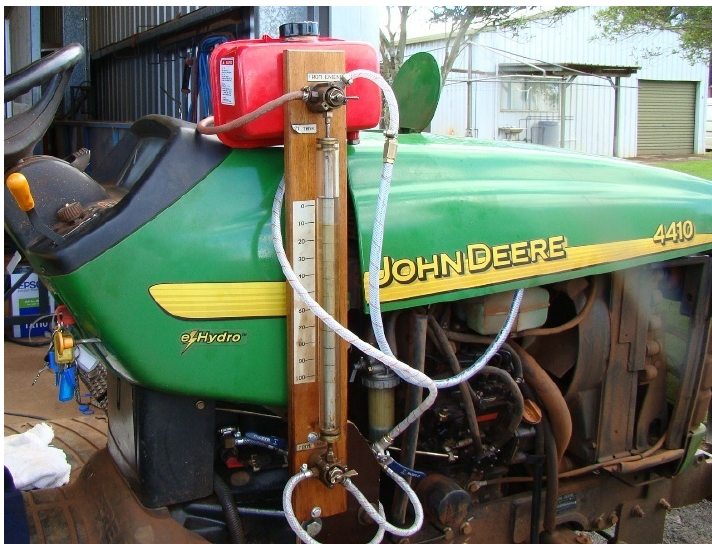
Figure 2. Fuel consumption measurement